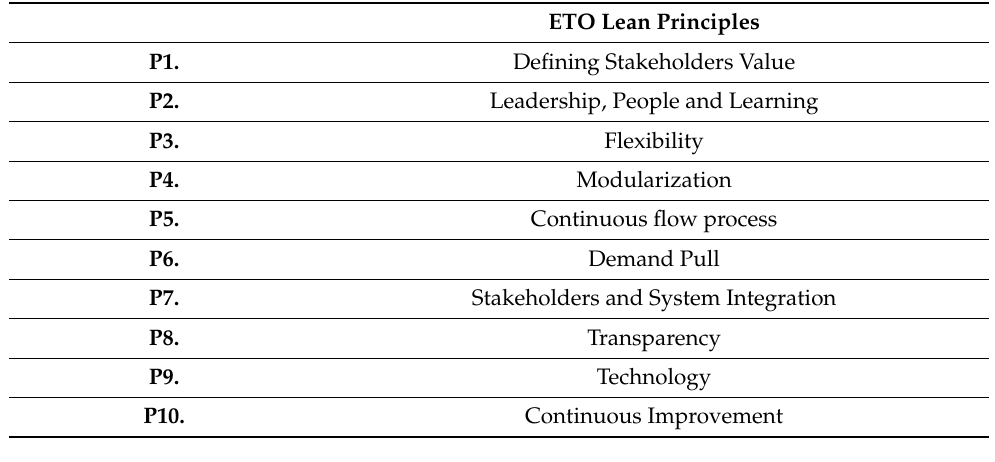
Table 1. The ten ETO lean principles from [30] with their Px. Abbreviation in bold font.